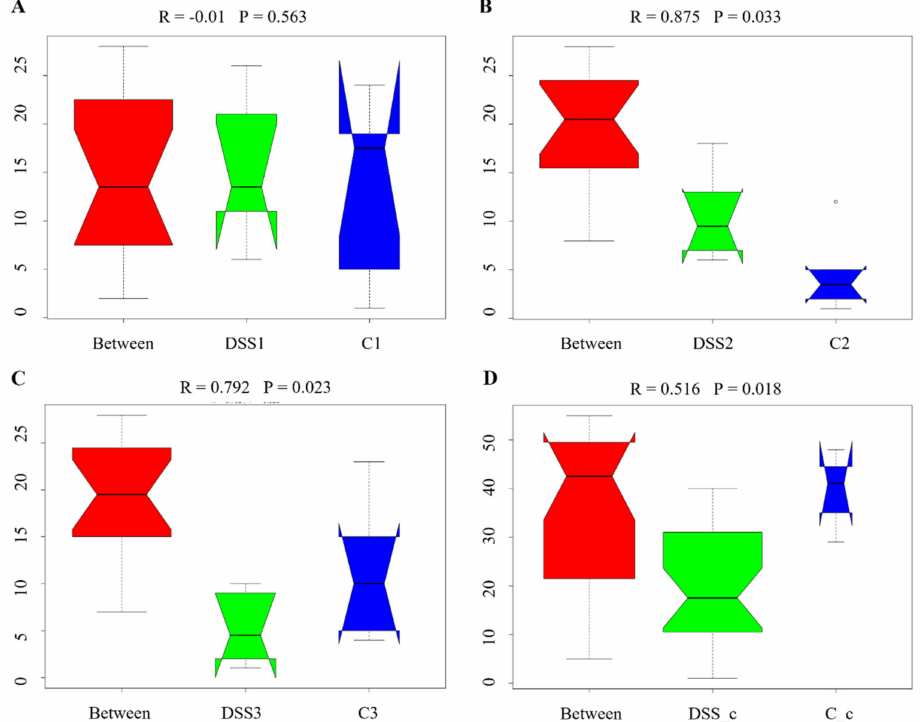
Figure 8. Anosim analysis results. R-value close to 1 shows that intra-group similarities are greater than inter-group similarities. “Between” represents the difference between groups; the greater distance shows the greater difference, and the thickness represents the sample size. Numbers next to the group names represent time-points of faecal samples collection: 1, before induction of colitis ( A ) (day 1); 2, at the end of DSS administration ( B ) (day 7); 3, at the end of experiment ( C ) (day 13); c shows caecal sample collected on the day of sacrifice ( D ). DSS, induced colitis; C, healthy control.